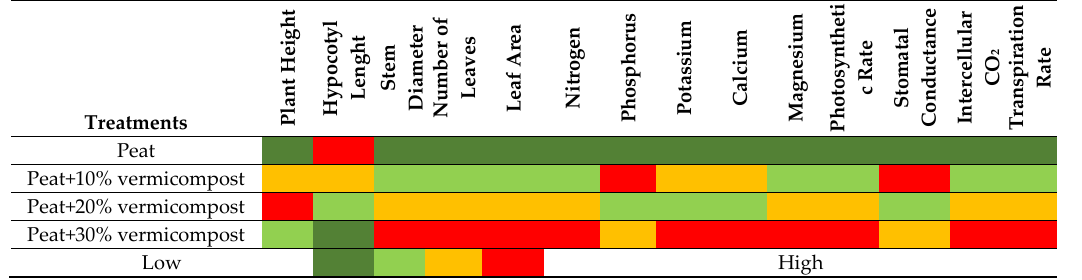
Figure 5. The effect of peat – vermicompost substrates on early and total cucumber yield ( A ), nitrate content in fruit of cucumber ( B ): 1 — peat; 2 — peat+10% vermicompost; 3 — peat+20% vermicompost; 4 — peat+30% vermicompost. Means with different letters are significantly different at the p < 0.05 level according to Tukey’s significant difference test. Error bars show standard deviation. The analyzed indices differ significantly between seedlings grown in peat without vermicompost and in peat with different ratios of vermicompost (Figure 6). Peat+10% ver- in peat+30% vermicompost substrates had more leaves and the largest leaf area. These